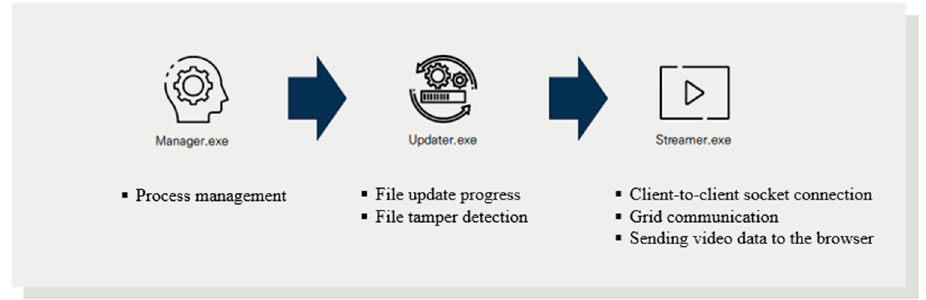
Figure 5. Client process flow.